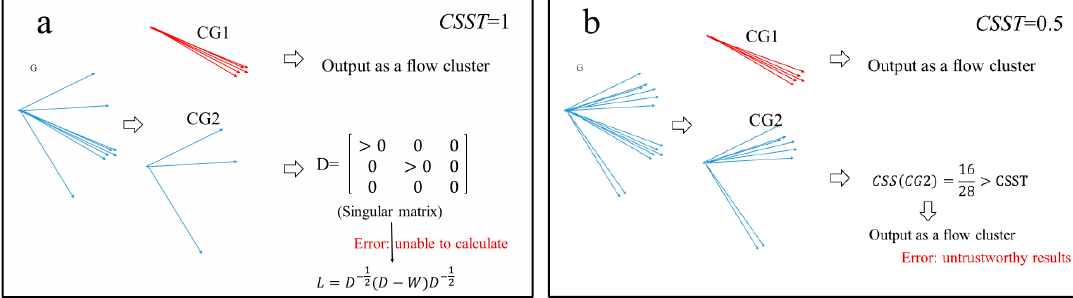
Figure 4. Illustration of the two problems (( a ) Problem 1 and ( b ) Problem 2).